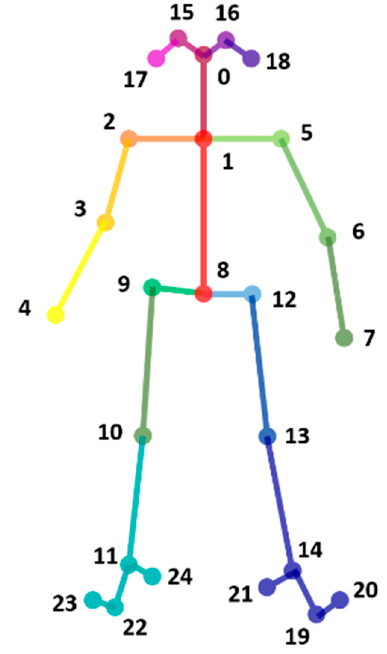
Figure 2. “BODY_25” human skeleton estimation model.